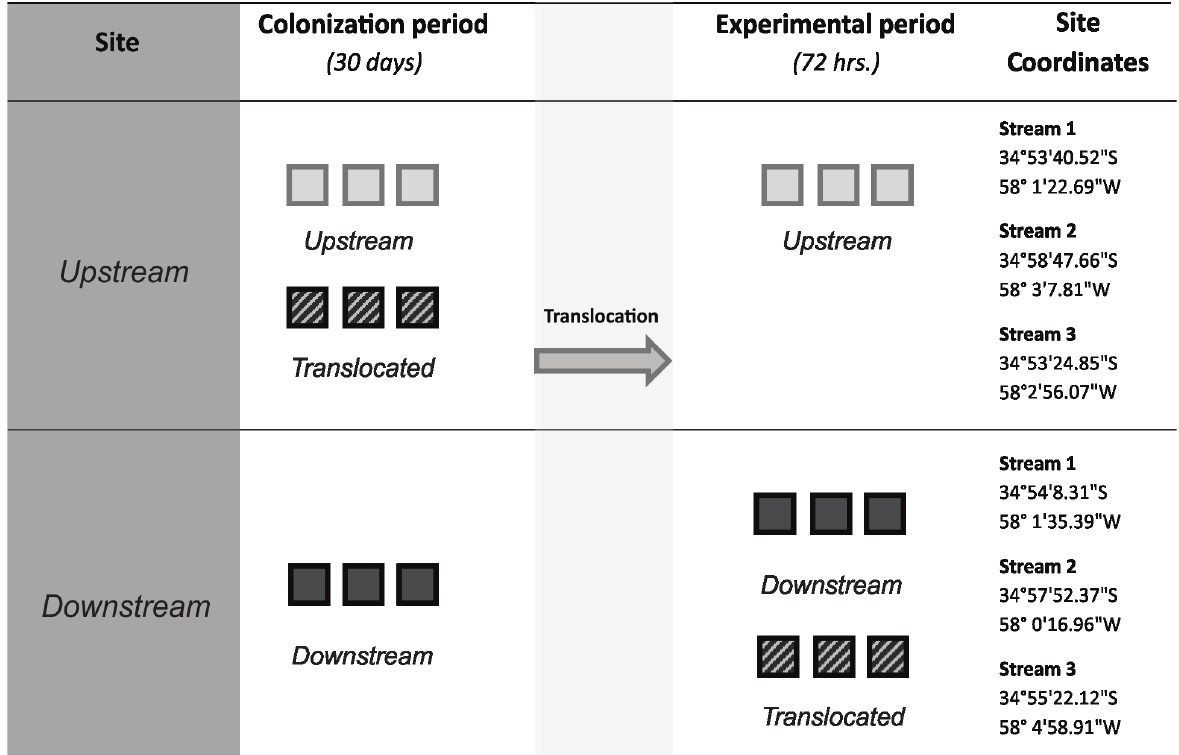
Figure 1. Experimental design used involving the translocation of germination trays with sediment from an Upstream site to a Downstream site within streams. The Upstream treatment trays (light gray squares) were colonized in the Upstream sites and kept there as controls; the Downstream treatment trays (dark gray squares) were colonized in the Downstream sites and kept there as controls; and the Translocated treatment trays (striped squares) were colonized in the Upstream sites and transferred to the Downstream sites for the experimental